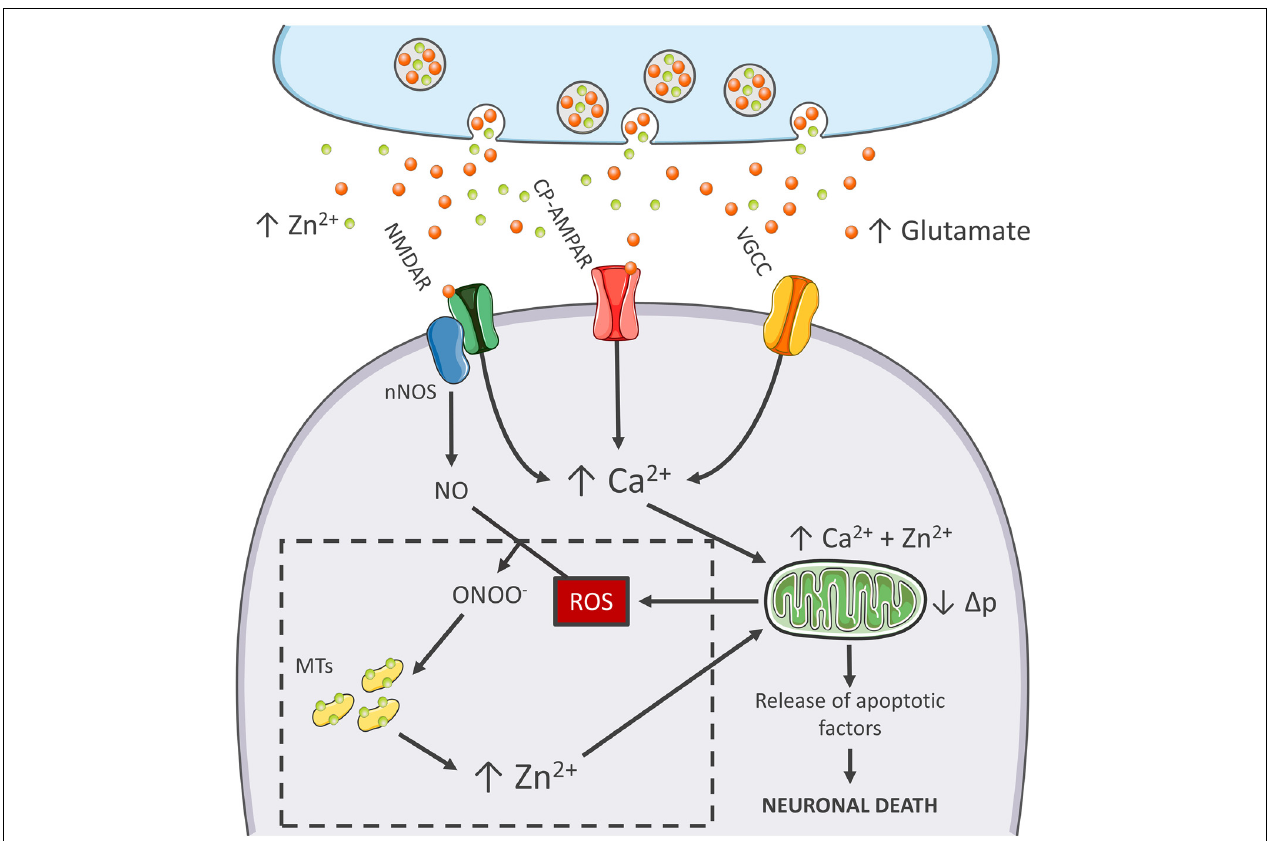
FIGURE 1 | Zn 2 + in the excitotoxic cascade. Aberrant release of glutamate from presynaptic terminals triggers NMDAR activation, which, in turn, promotes Ca 2 + entry and generation of RNS and ROS of mitochondrial and extramitochondrial origin. The surge of ROS and RNS is required for intraneuronal Zn 2 + mobilization from metallothioneins (MTs; Zn 2 + buffering redox-sensitive proteins prone to release Zn 2 + following oxidative stimuli). Intraneuronal Zn 2 + rises target mitochondria and, along with Ca 2 + , contribute to the organelle impairment. Dysfunctional mitochondria fail to cope with Ca 2 + clearance and further exacerbate Ca 2 + dysregulation and ROS production. The lack of ROS generation in nNOS (+) neurons is a critical point of divergence in the excitotoxic cascade. By missing the injurious interaction between ROS and RNS, the subpopulation fails to mobilize neurotoxic Zn 2 + , prevents mitochondrial failure, and eventually neuronal death (dashed line box). In the general population of nNOS ( − ) neurons, pharmacological Zn 2 + chelation prevents the full development of the excitotoxic cascade and mimics nNOS (+) cells’ behavior. These findings lend support to the idea that intraneuronal Zn 2 + release is a critical regulator of excitotoxicity.